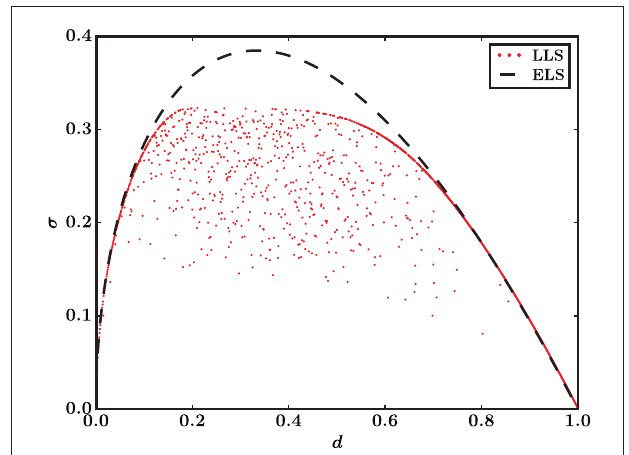
FIGURE 8 | Stress σ vs. damage d in the ELS model and the LLS model on a square lattice. The ELS curve has been calculated analytically via Equation (1), and the LLS result is a simulation of a single sample ( N = 1,024 2 ). For clarity, the LLS result shows only every 800th data point. The threshold distribution is P ( t ) = t 2 for both models.